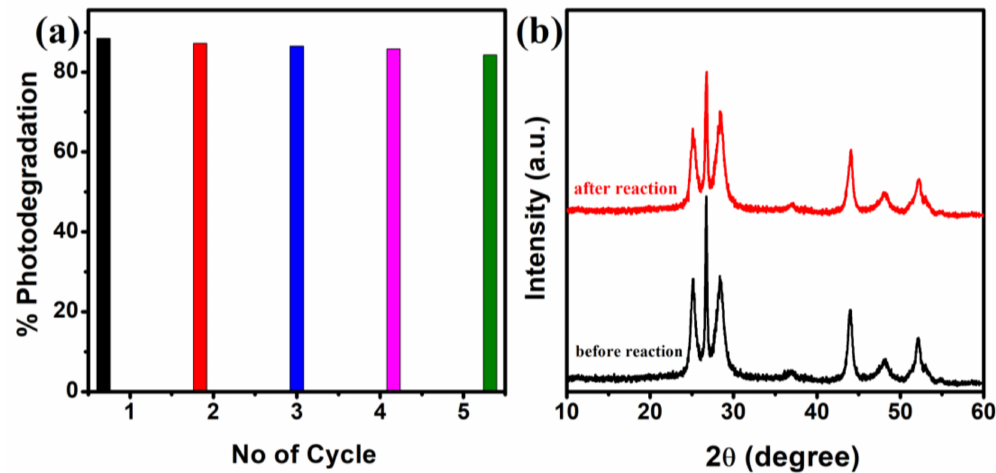
Figure 9. Stability test of CdS NRs for five cycles ( a ), XRD pattern for CdS NRs before the activity and after recycling five times for RhB photodegradation ( b